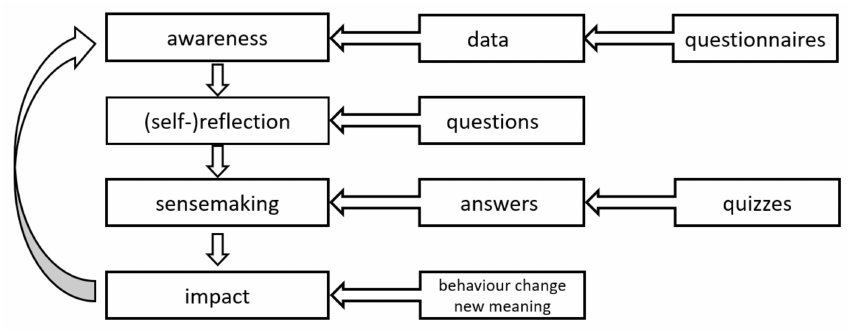
Figure 1. The learning analytics process model adaptation of